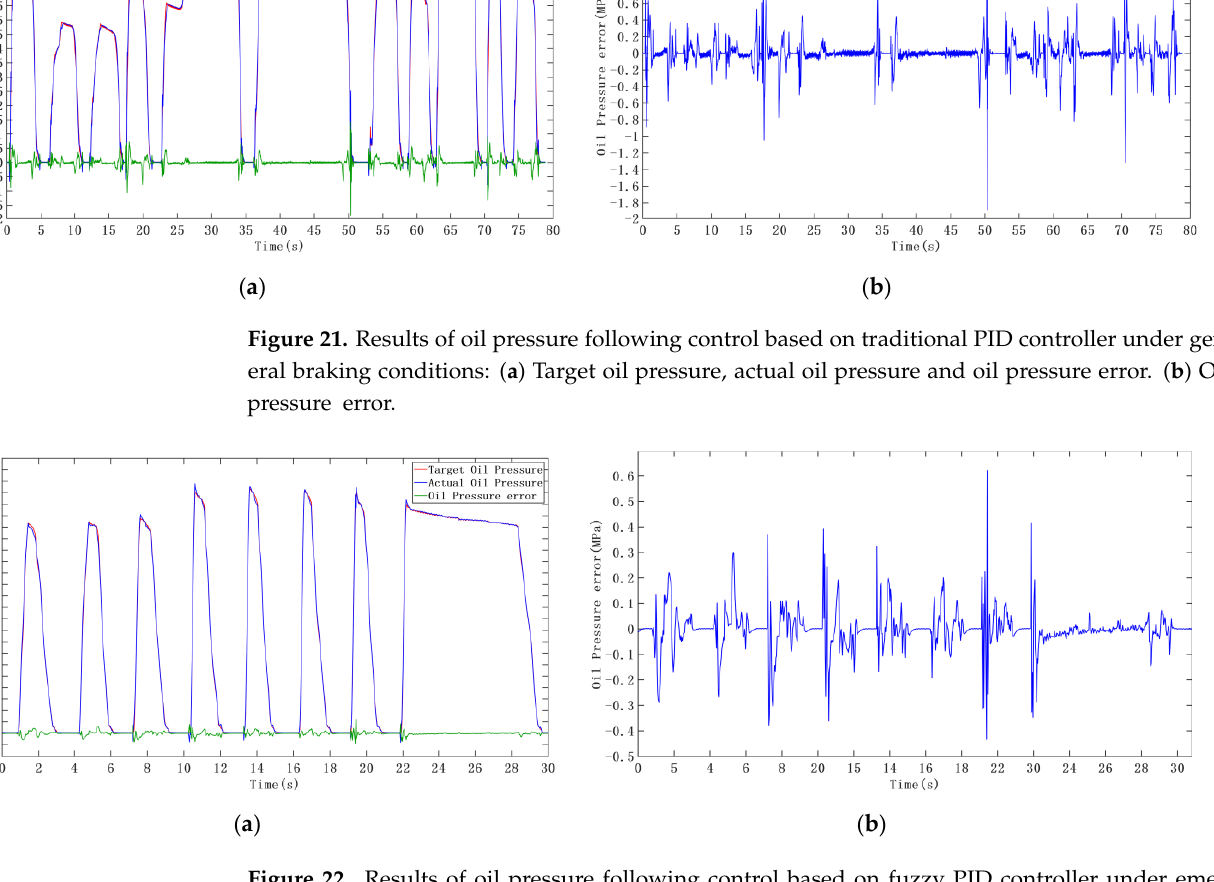
Figure 22. Results of oil pressure following control based on fuzzy PID controller under emer- gency braking conditions: ( a ) Target oil pressure, actual oil pressure and oil pressure error. ( b ) Oil pressure error.